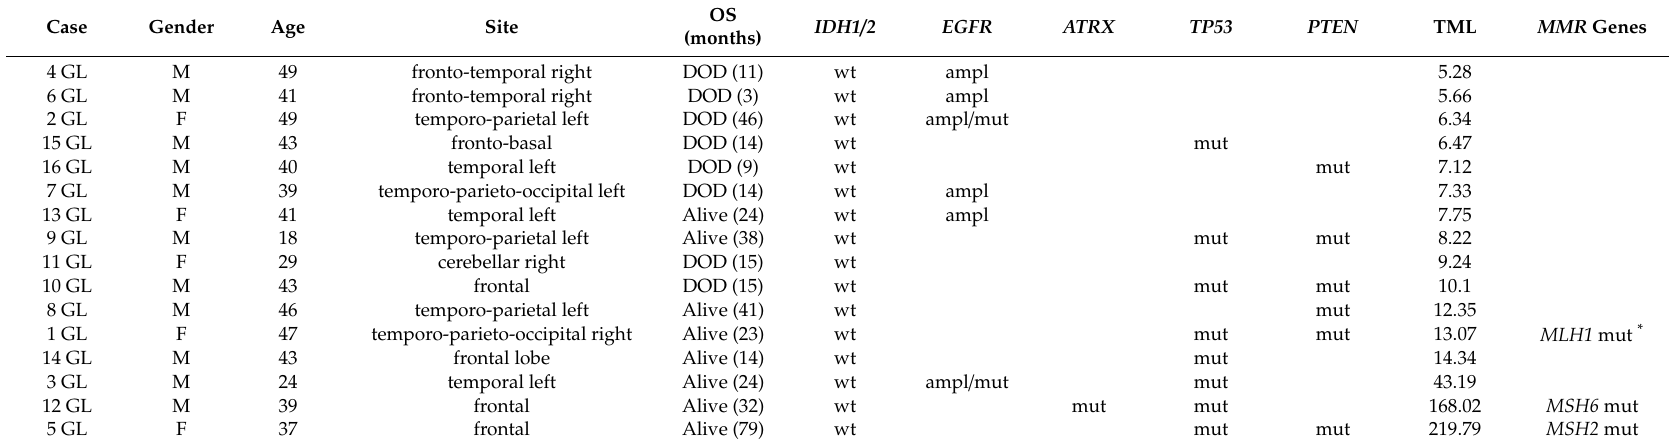
Table 1. Clinico-pathological features and main molecular data of 16 IDH -wt GBMS in adult patients younger than 55 years. Cases are ordered by increasing TML. Case